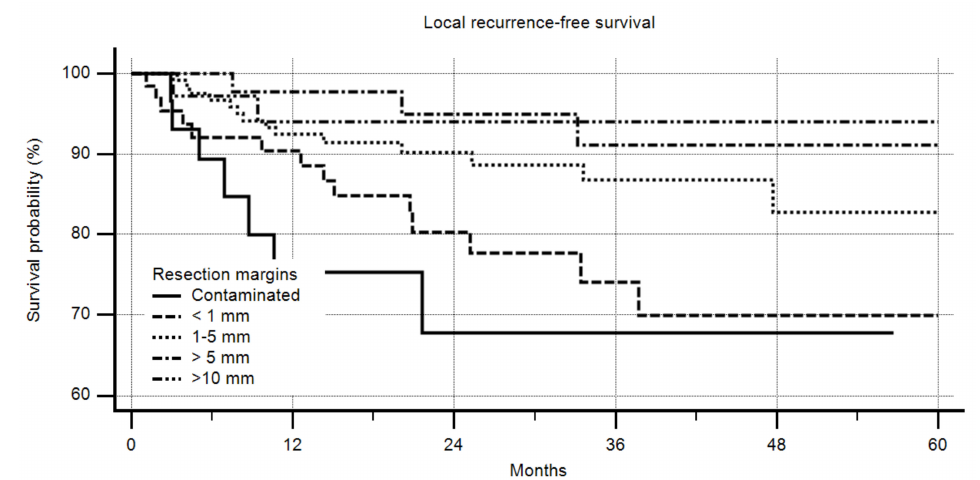
Figure 2. Local recurrence-free survival by margin in detail, n = 305, p = 0.0045. In multivariate analysis, only age, adjuvant radiotherapy (RTX), and chemotherapy (CTX) had a significant impact on local recurrence-free survival (LRFS) (Table